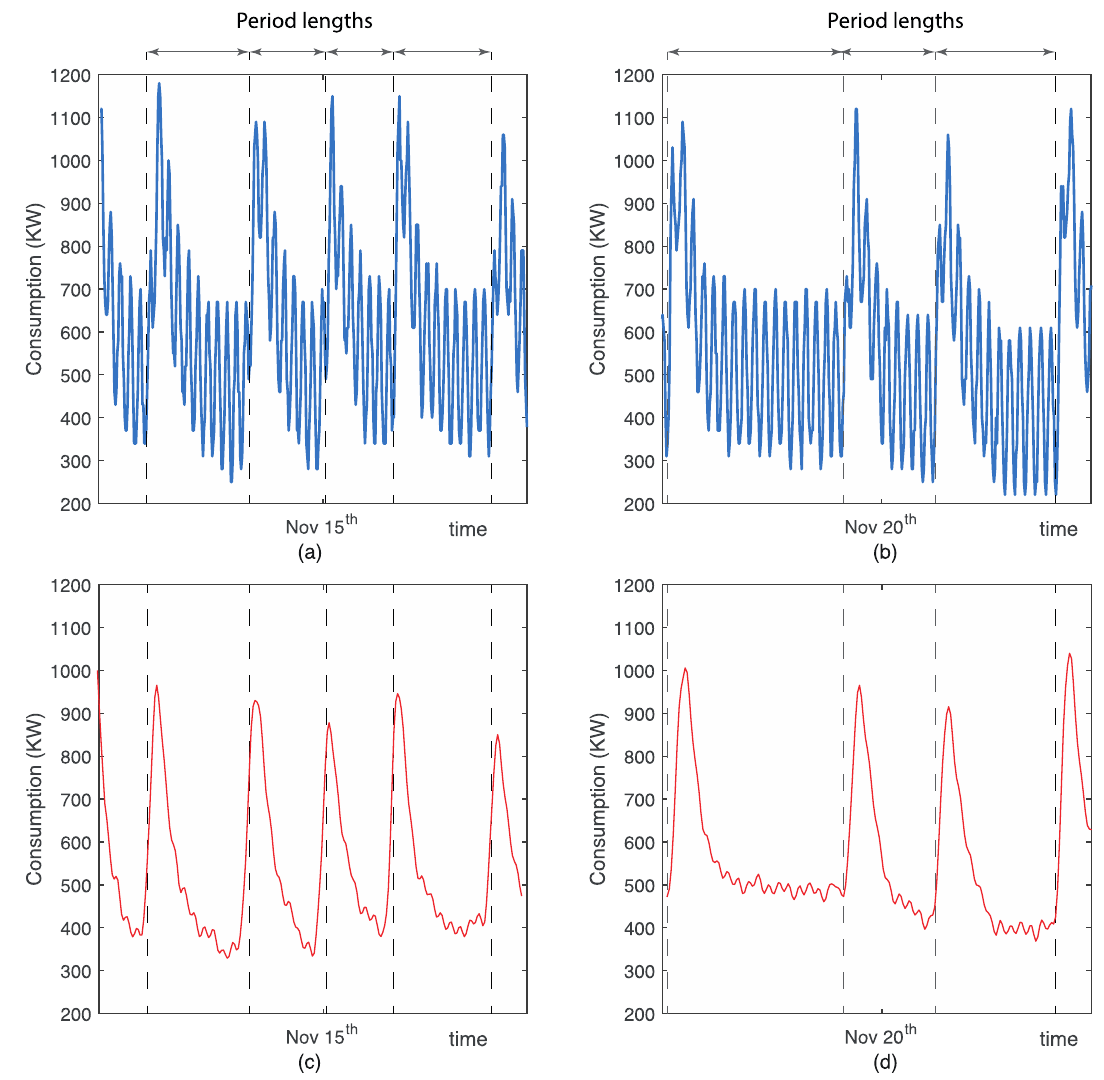
Figure 4. Close-up version of Figure 3, where different seasonal patterns can be located: a first pattern along the whole series, with sort oscillations as shown in ( a , b ); and a second pattern covering the consumption peaks, as shown in ( c , d ). This second pattern has a different length on every appearance.